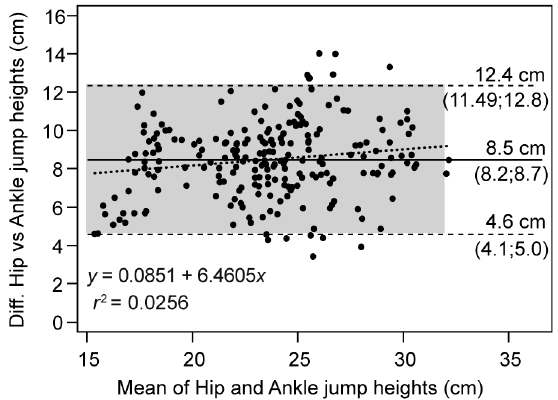
Figure 4. Bland–Altman plot for differences between devices placed on the hip and ankle. Solid lines: mean differences (systematic error); dashed lines: upper and lower LoA (random error); dotted lines: regression line of the differences between devices.